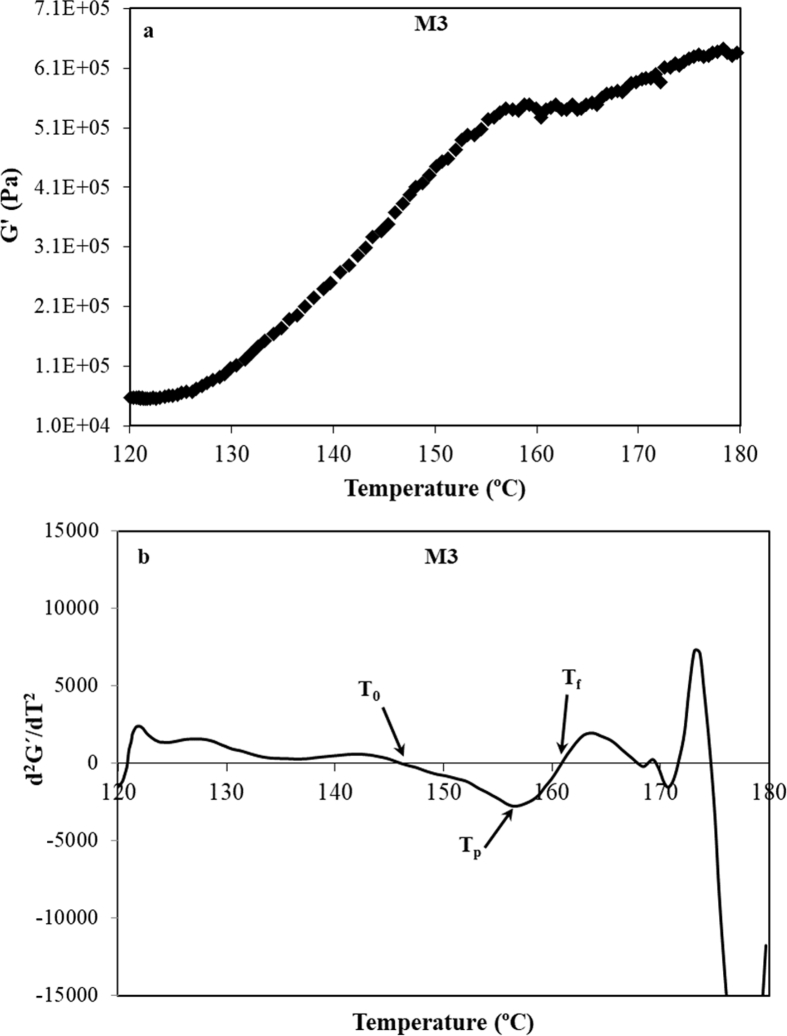
Experimental data of G′ vs temperature (a) and second derivate of G′(T) (d2G'/dT2) for DMTA experimental data of CD during M3 transition.